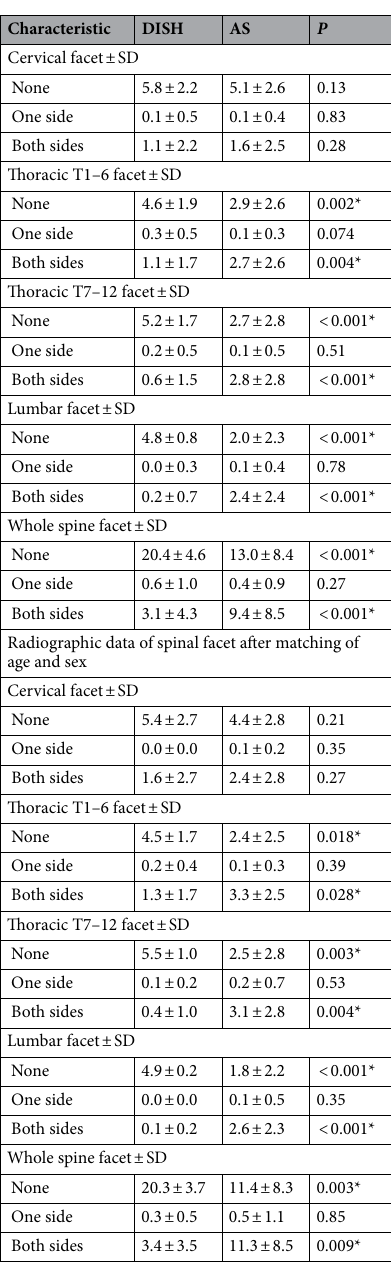
Table 4. Radiographic data of spinal facet fusion. DISH Diffuse idiopathic skeletal hyperostosis, AS Ankylosing spondylitis, SD standard deviation. * P <